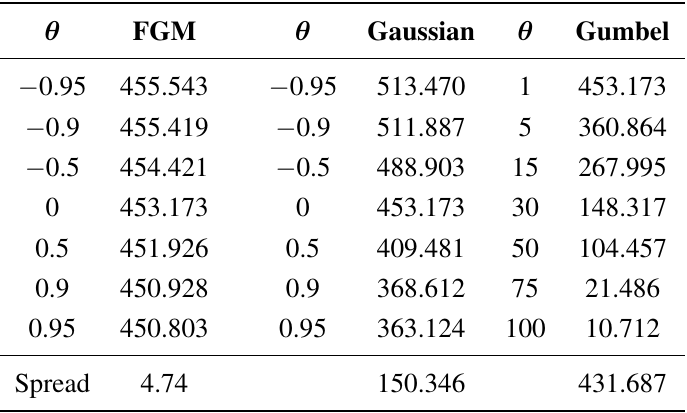
(5) for various Z